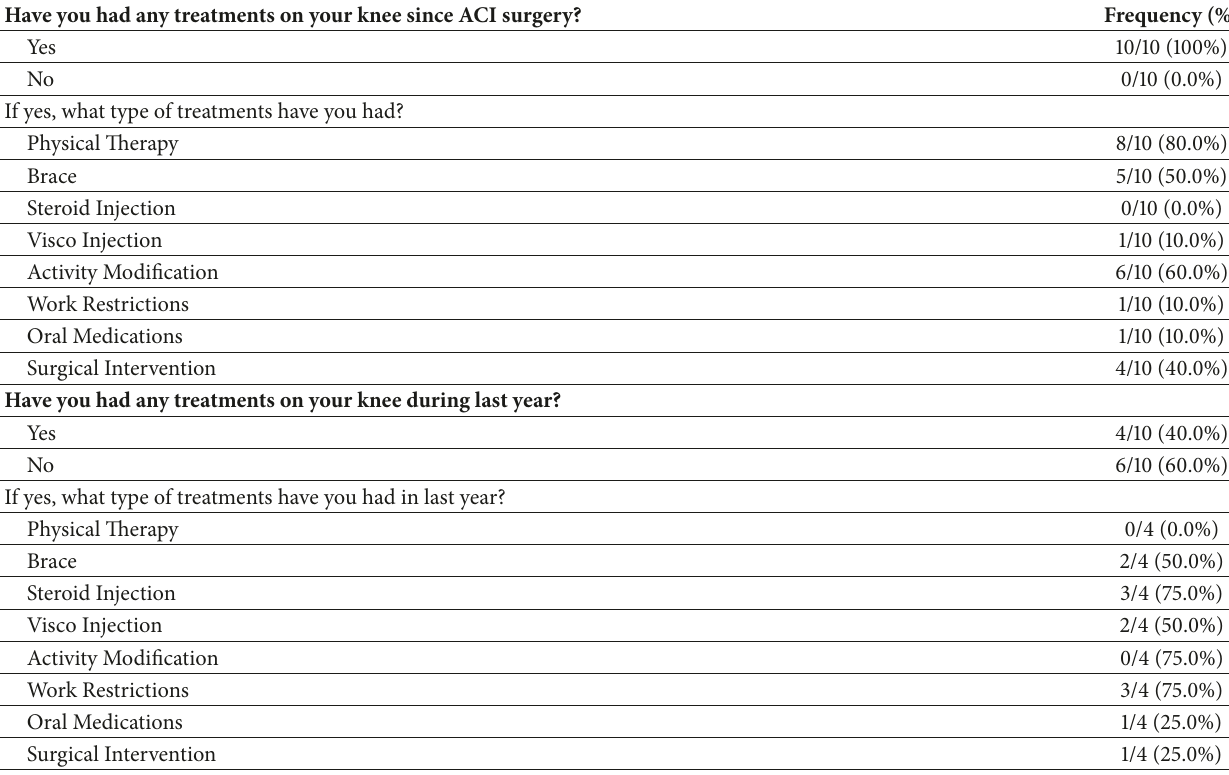
Table 3: Description of treatment history.